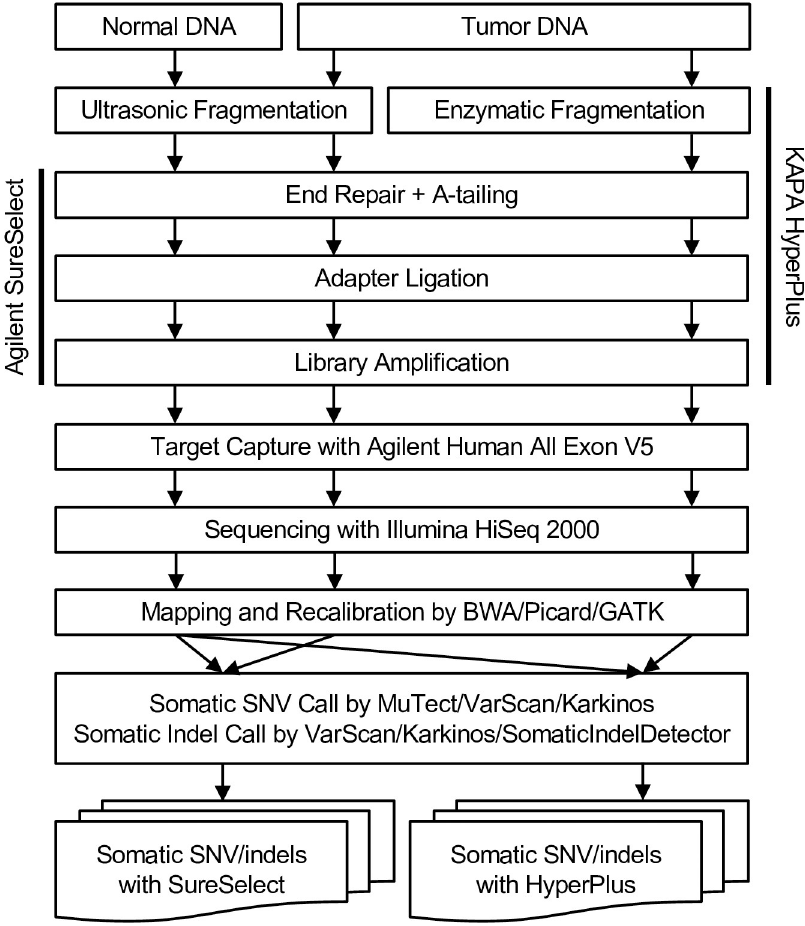
Fig 1. Experimental procedure to prepare sequencing libraries using Agilent SureSelect or KAPA HyperPlus kits, and the analytical pipeline to call somatic SNVs and indels. A major difference between the two kits is the use of ultra-sonication versus enzymatic treatment with an endonuclease for DNA fragmentation. The same tumor DNA samples were used for library preparation, and the SureSelect kit was used for all of the paired normal DNA in the somatic mutation